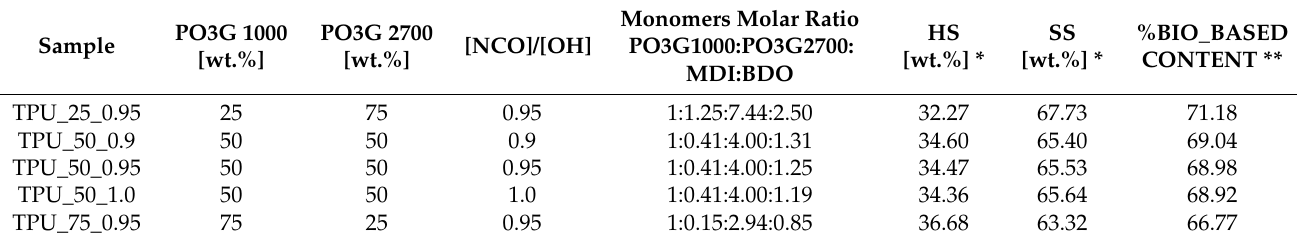
Figure 7. The schematic synthesis of green TPUs obtained by using the mixture of prepolymers. Table 7. Codes and formulation (molar ratio [NCO]/[OH], hard segments (HS), and soft segments (SS)) of synthesized green